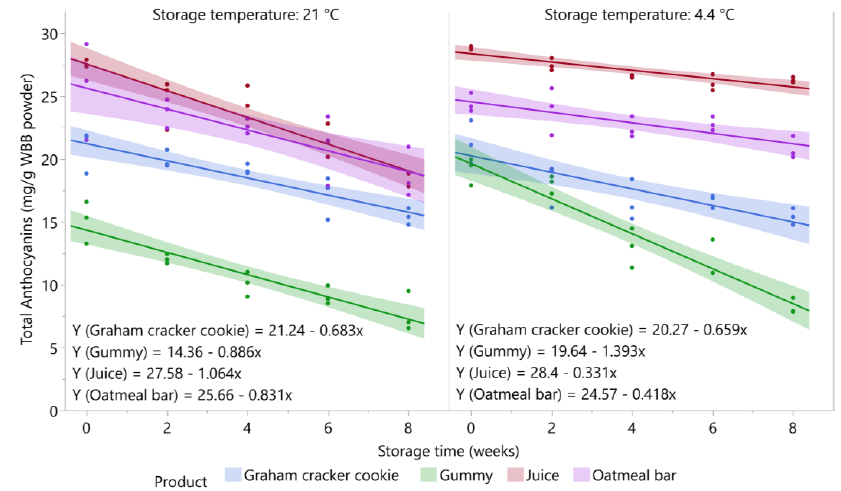
Figure 2. Stability of total anthocyanins in blueberry stored at 21 ◦ C and 4.4 ◦ C ( n = 3 / time point). Shaded area around lines represents 95% confidence intervals for predicted values.